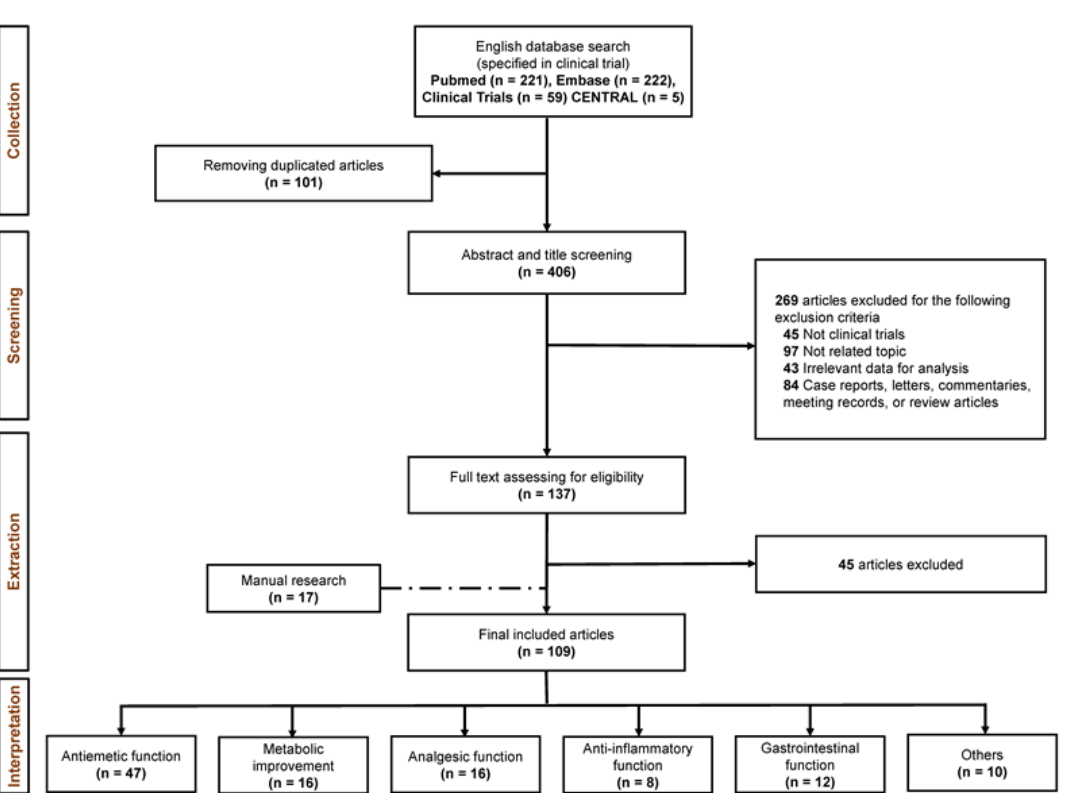
Figure 1. The workflow of systematical search on ginger randomized clinical trials (RCTs) with five categorized substantial functions.